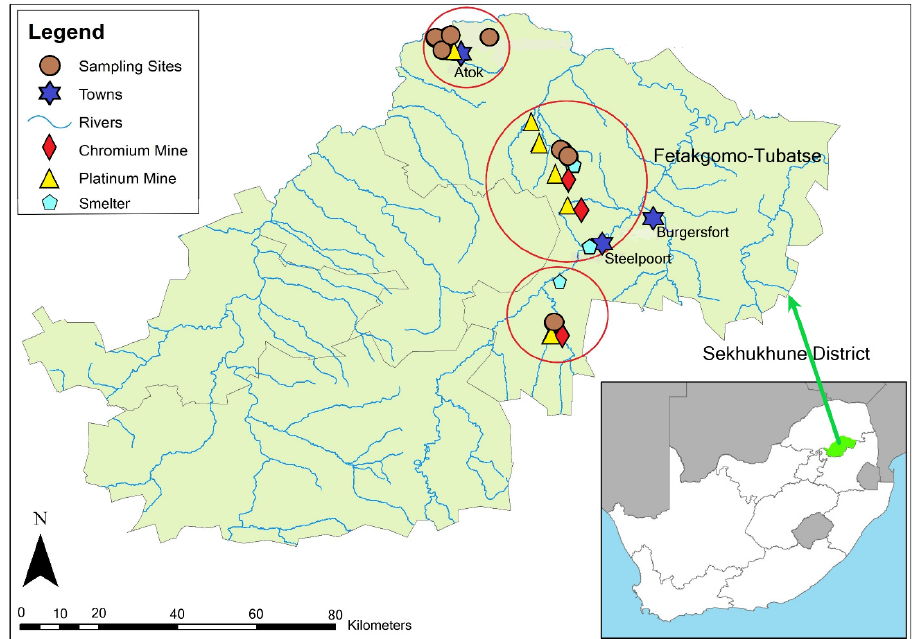
Figure 1. Sampling sites around three mining–smelting agglomerations (red circles) in the Sekhukhune District of Limpopo Province, South Africa.